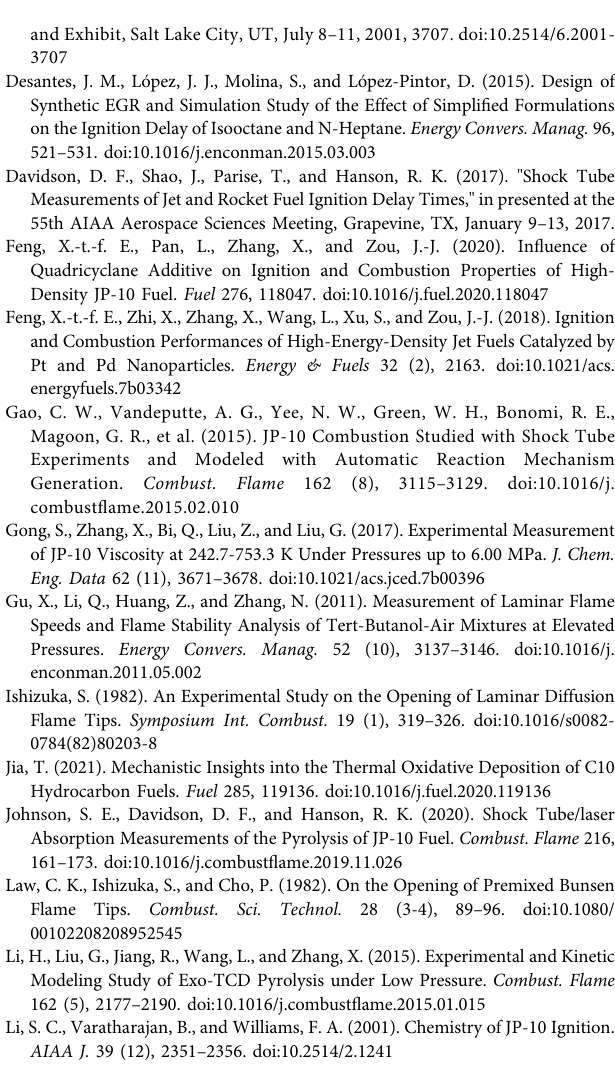
Supplementary Table S1 | Measured ignition delay times of